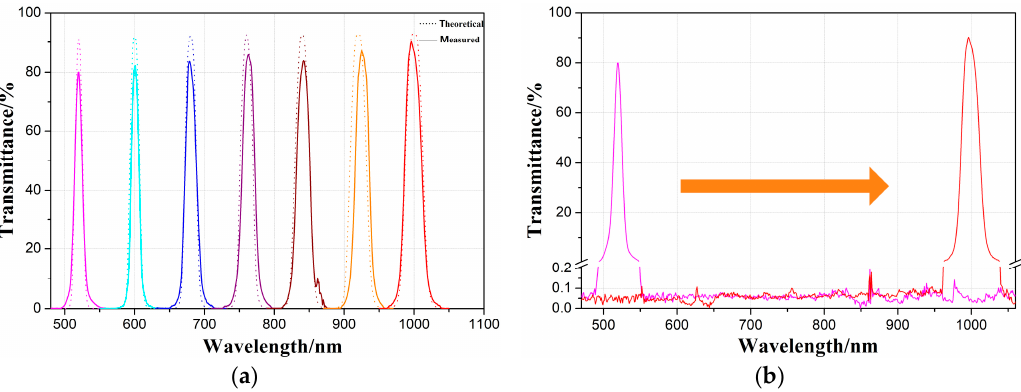
Figure 10. Measured spectrum of LVF when Spot = 0.2 mm. ( a ) Measured and theoretical transmittance spectrum for each sampling point and ( b ) measured transmittance spectrum in the whole operating range of 520–1000 nm.